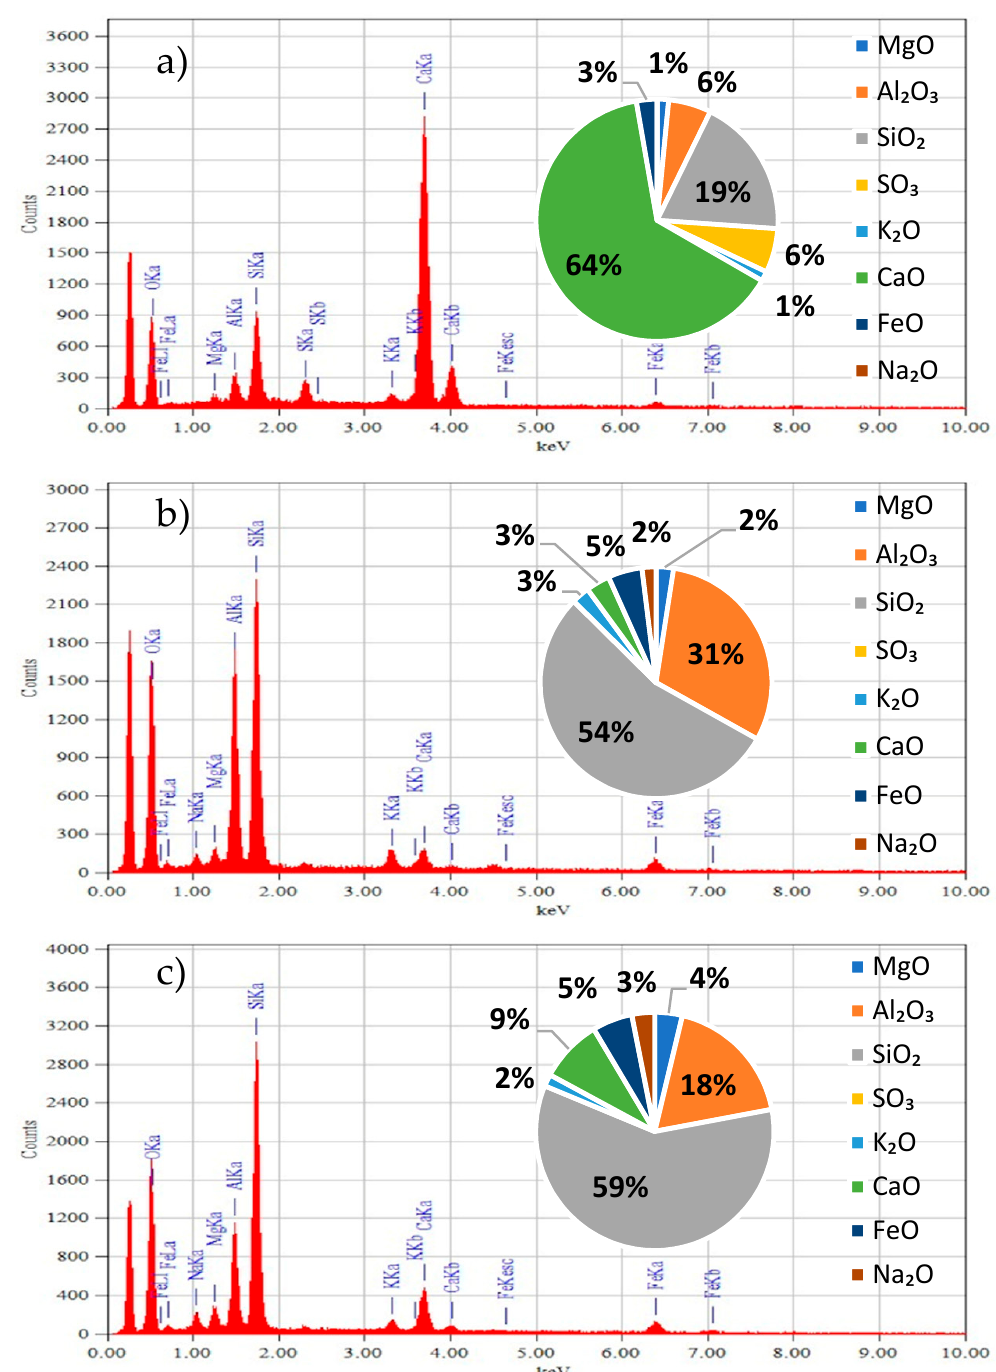
Figure 6. X-ray diffraction chemical composition analysis: ( a ) cement, ( b ) fly ash, and ( c ) granite powder.